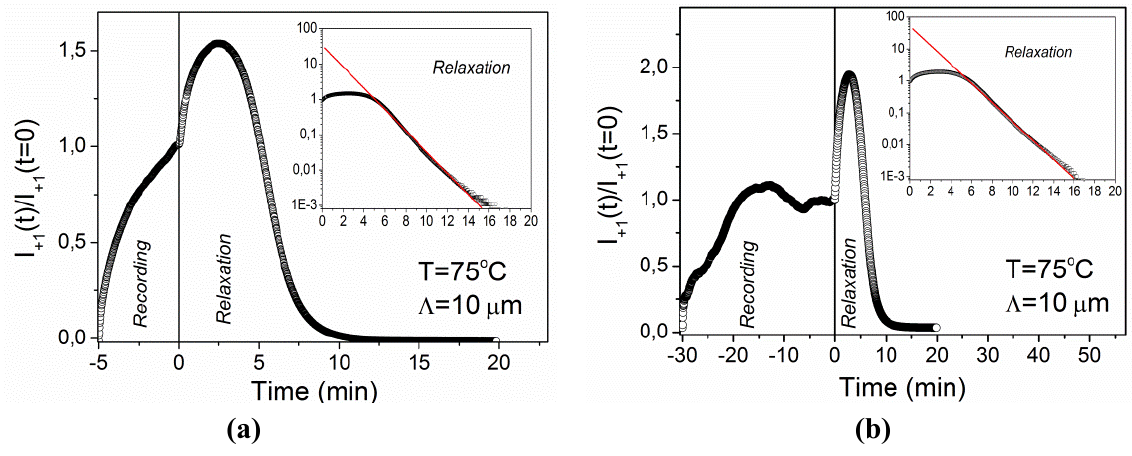
Figure 6. Time dependence of diffracted intensity during recording and relaxation of the grating with Λ = 10 μ m at T = 75 ° C: ( a ) recording for 5 min; ( b ) recording for 30 min. The insets show the relaxation process on a logarithmic scale. Solid lines are fits to single-exponential